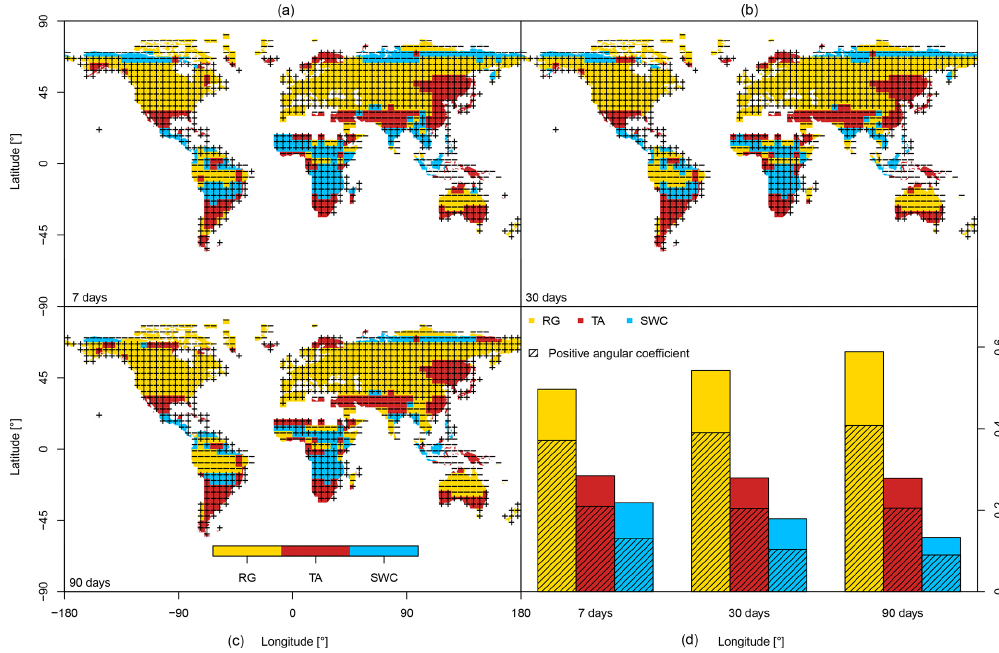
Figure 1. Maps of the dominant drivers calculated over the entire time series and sign of their angular coefficients in a multilinear regression. Results are shown for three temporal resolutions, namely 7, 30 and 90d. (d) Frequency of each dominant variable for the three analysed temporal resolutions; dashed areas represent the frequency of positive angular coefficients.